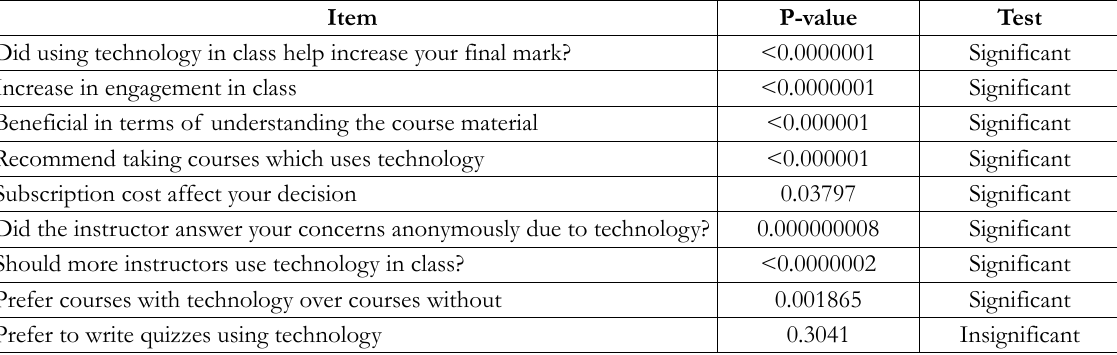
Table 2. p-values of one-sided z